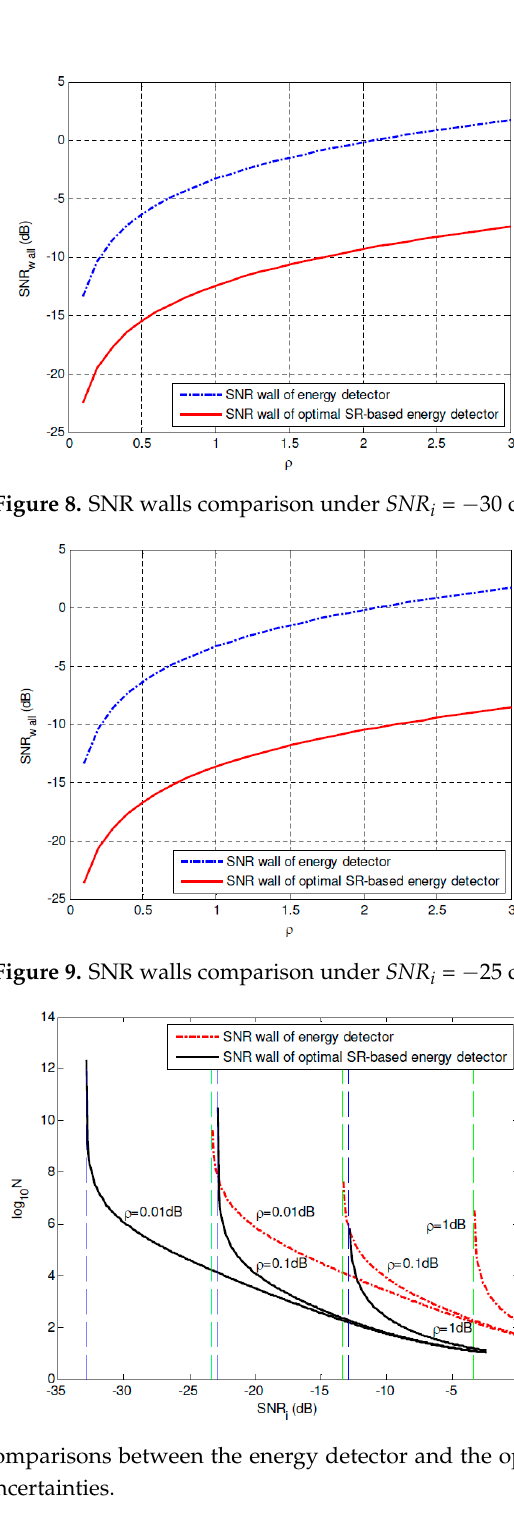
Figure 10. SNR wall comparisons between the energy detector and the optimal SR-based detector under different noise uncertainties.